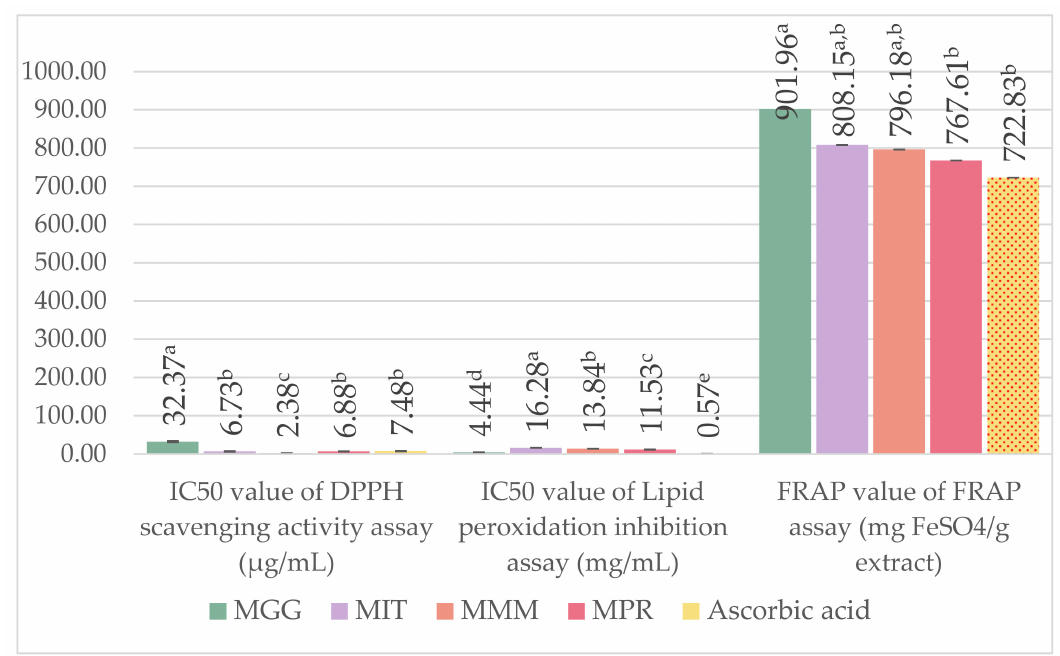
Figure 5. IC50 of DPPH scavenging activity assay and lipid peroxidation inhibition assay, FRAP value of FRAP assay of four Mucuna seed extracts compared with ascorbic acid. Values are expressed as mean ± SD ( n = 3); a, b, c, d, and e show significant differences among samples at p < 0.05. The FRAP assay is based on reducing the ferric-tripyridyl triazine complex (Fe 3+ - TPTZ) to ferrous-tripyridyl-triazine (Fe 2+ -TPTZ) by antioxidants. The results showed